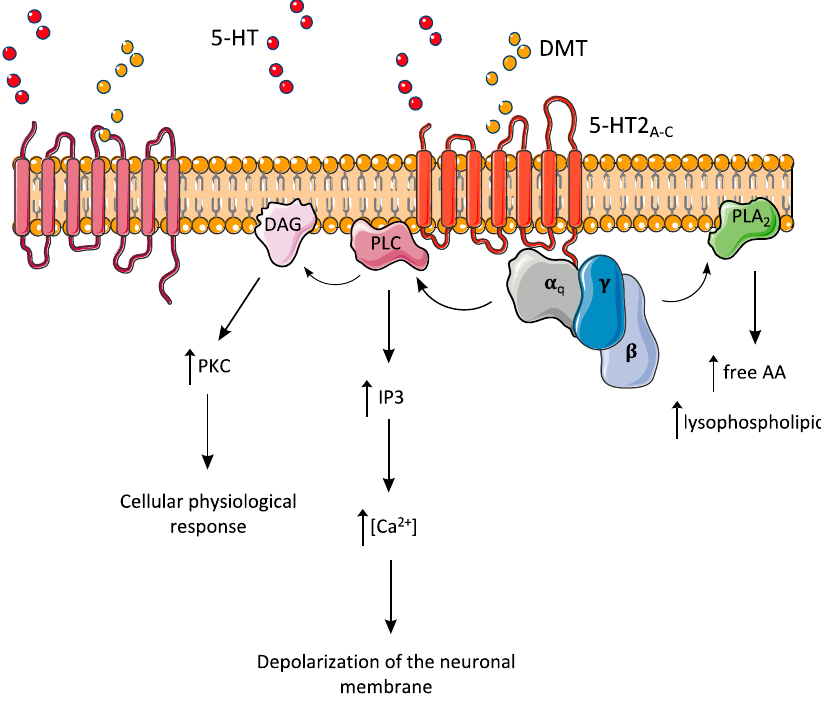
Figure 4. Main intracellular signalling pathways after activation of 5-HT2 A-C receptors by N , N - dimethyltryptamine (DMT). The main downstream signalling pathway of these receptors, for a long